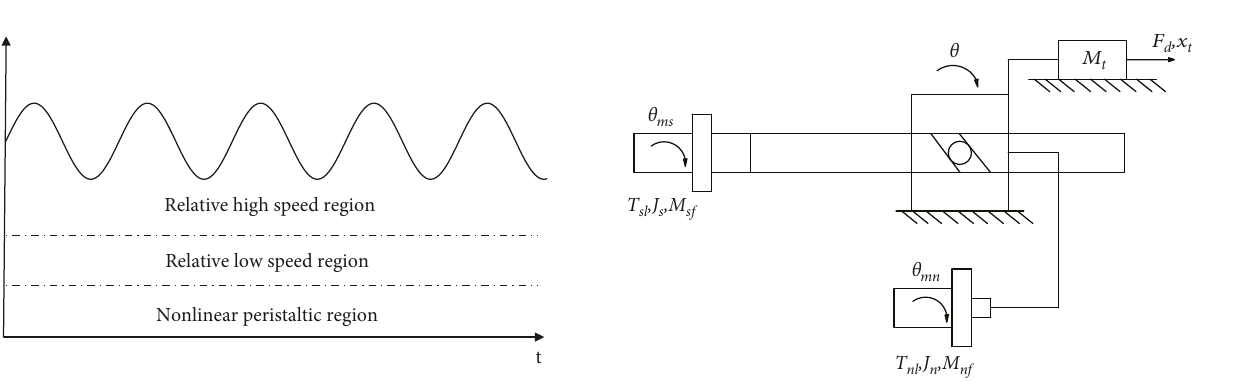
Figure 3: Dynamic model of the two-axis differential microfeed